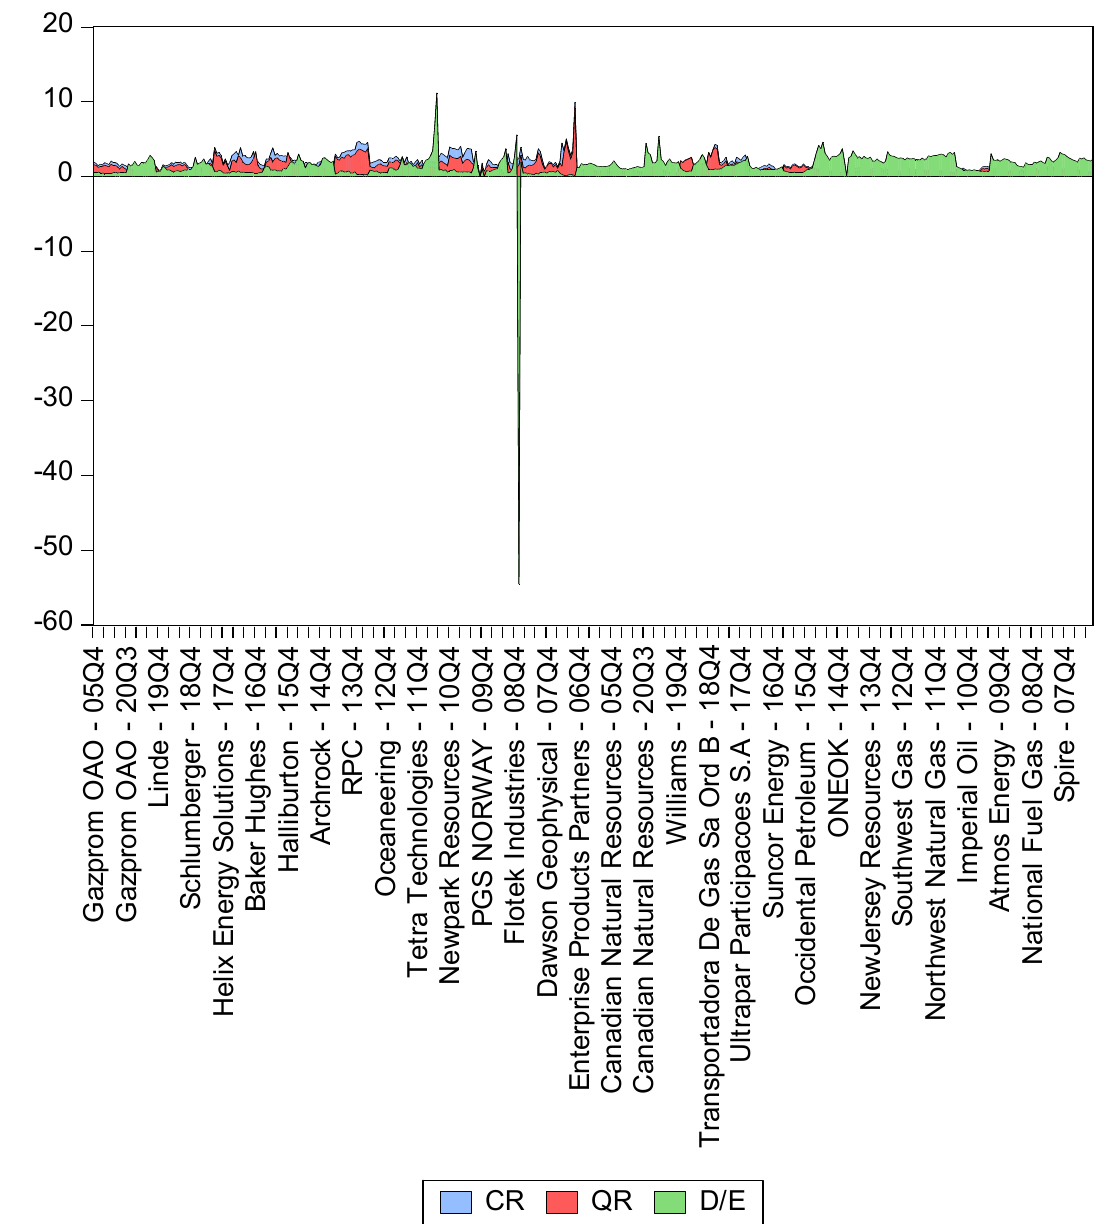
Figure 2. Evolution of equilibrium indicators for gas companies.